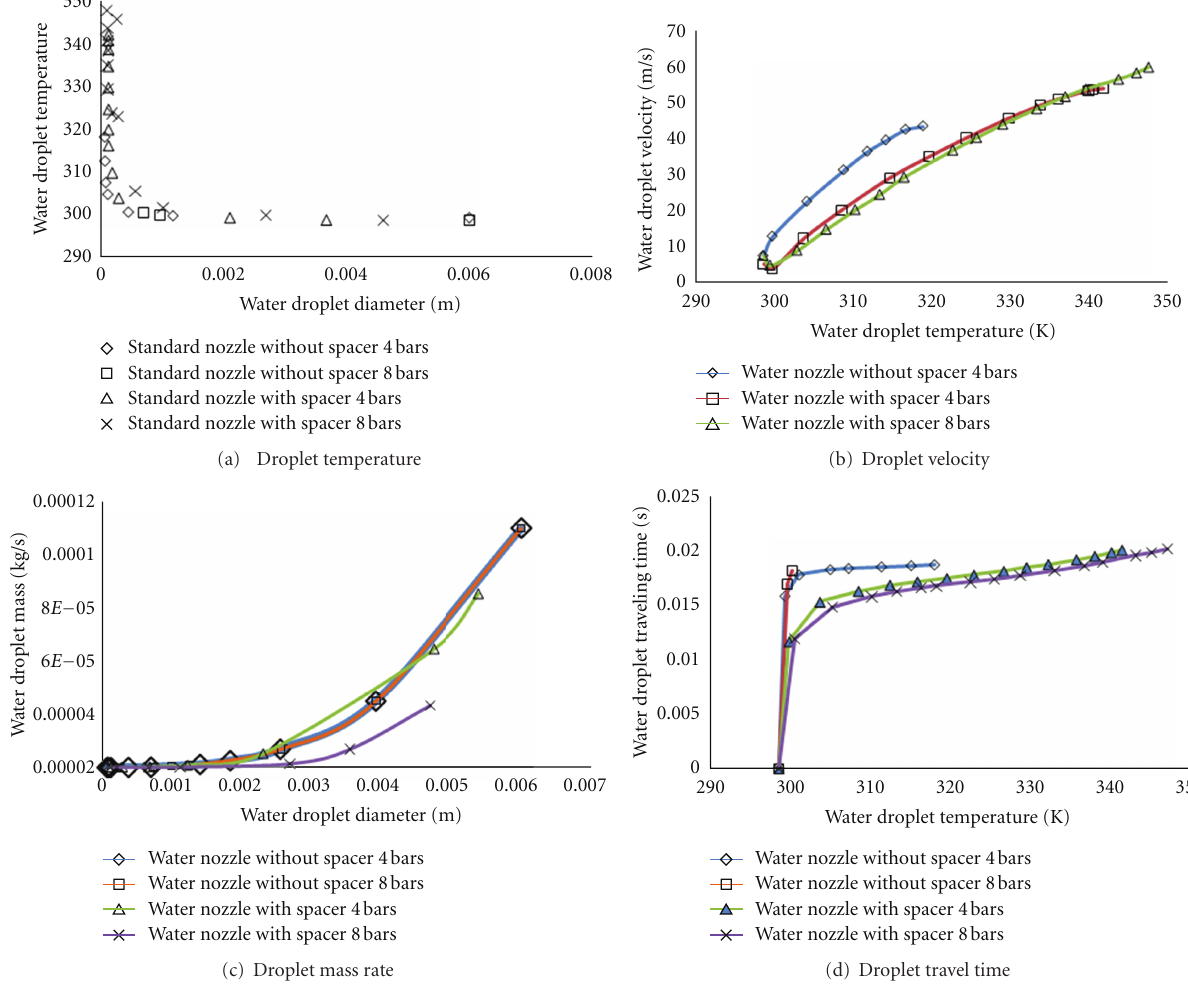
Figure 7: Comparison of water droplet behaviour at the loading speed of 800 rpm/T ∧ 0.5 and water injection pressures of 4 bars and 8 bars at 90 ◦ water injection angle with and without a